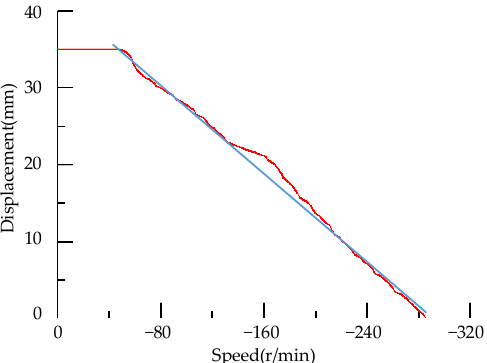
Figure 8. System negative dead-zone curve. The red line is the displacement curve of the hydraulic cylinder in the negative dead-zone of the system, and the blue line is the reference line based on the compensation principle, which is used to obtain the estimated parameters of the dead-zone.